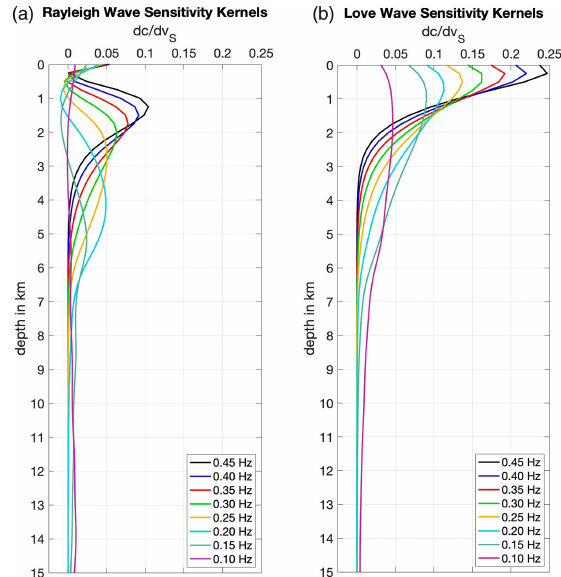
Figure 3. Sensitivity kernels from Computer programs in seismol- ogy (Herrmann, 2013) and the velocity model from Löer et al. (2020). (a) Rayleigh wave sensitivity kernels vs. depth. (b) Love wave sensitivity kernels vs.